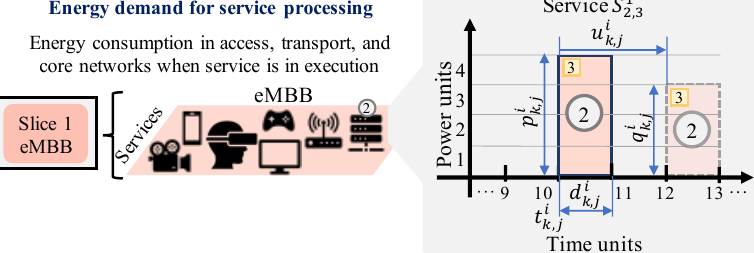
Figure 4. Graphical representation of the characterization of a service that is part of a network slice. Description: Service 2, with a priority level 3, and belonging to the network slice 1. Parameters: = 10, d 1 = 1, p 1 = 4, u 1 = + 2 ( forward ), v 1 t 1 2,3 2,3 2,3 2,3